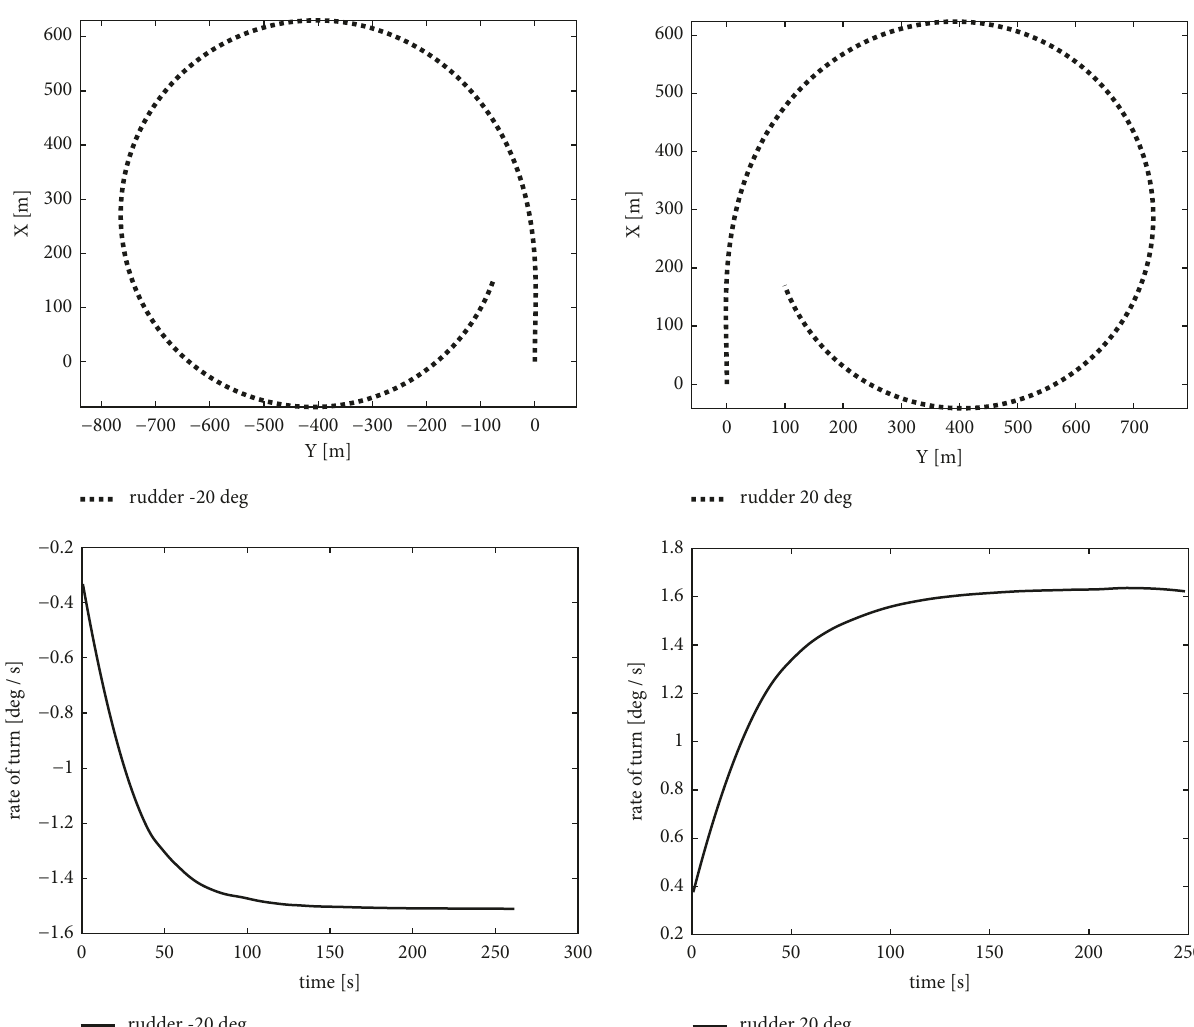
Figure 7: Results of LaiDyn simulations for the considered ro-pax for rudder setting 20